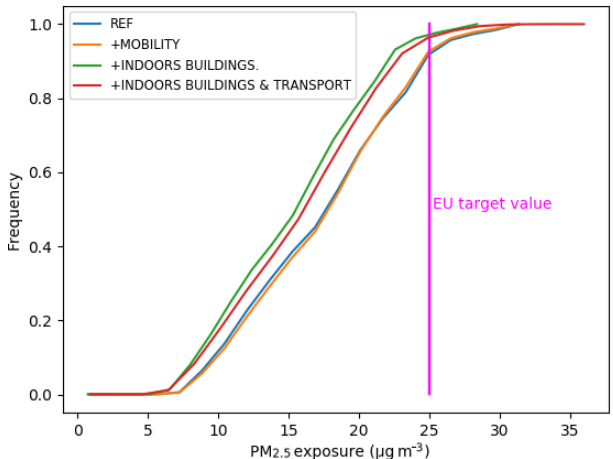
Figure 12. Cumulative distributions of exposure to PM 2 . 5 resulting for simulations integrating increasing levels of complexity in the input